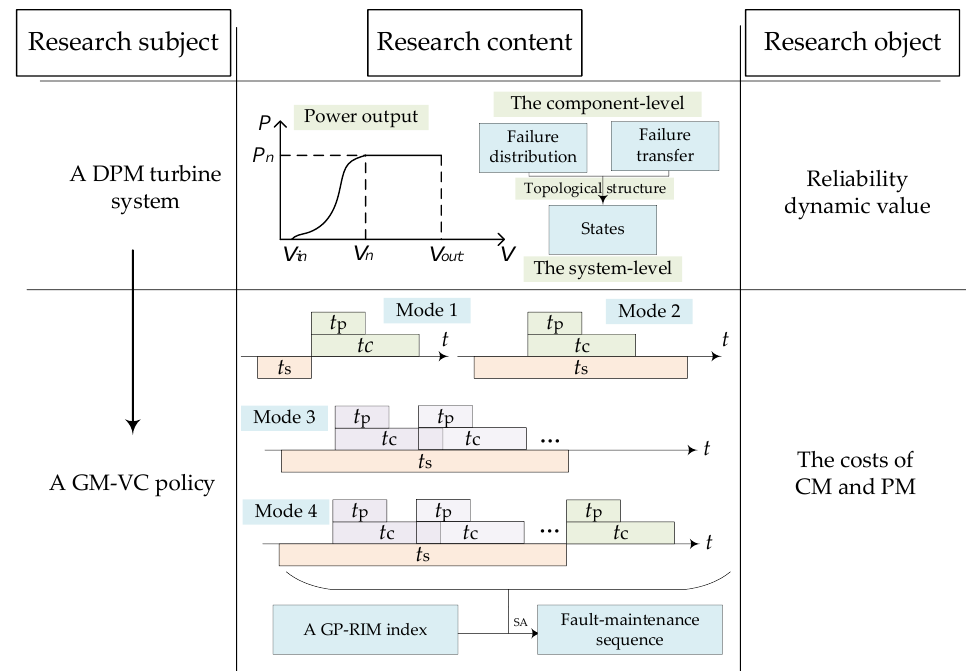
Figure 1. The technical route for the proposed method.